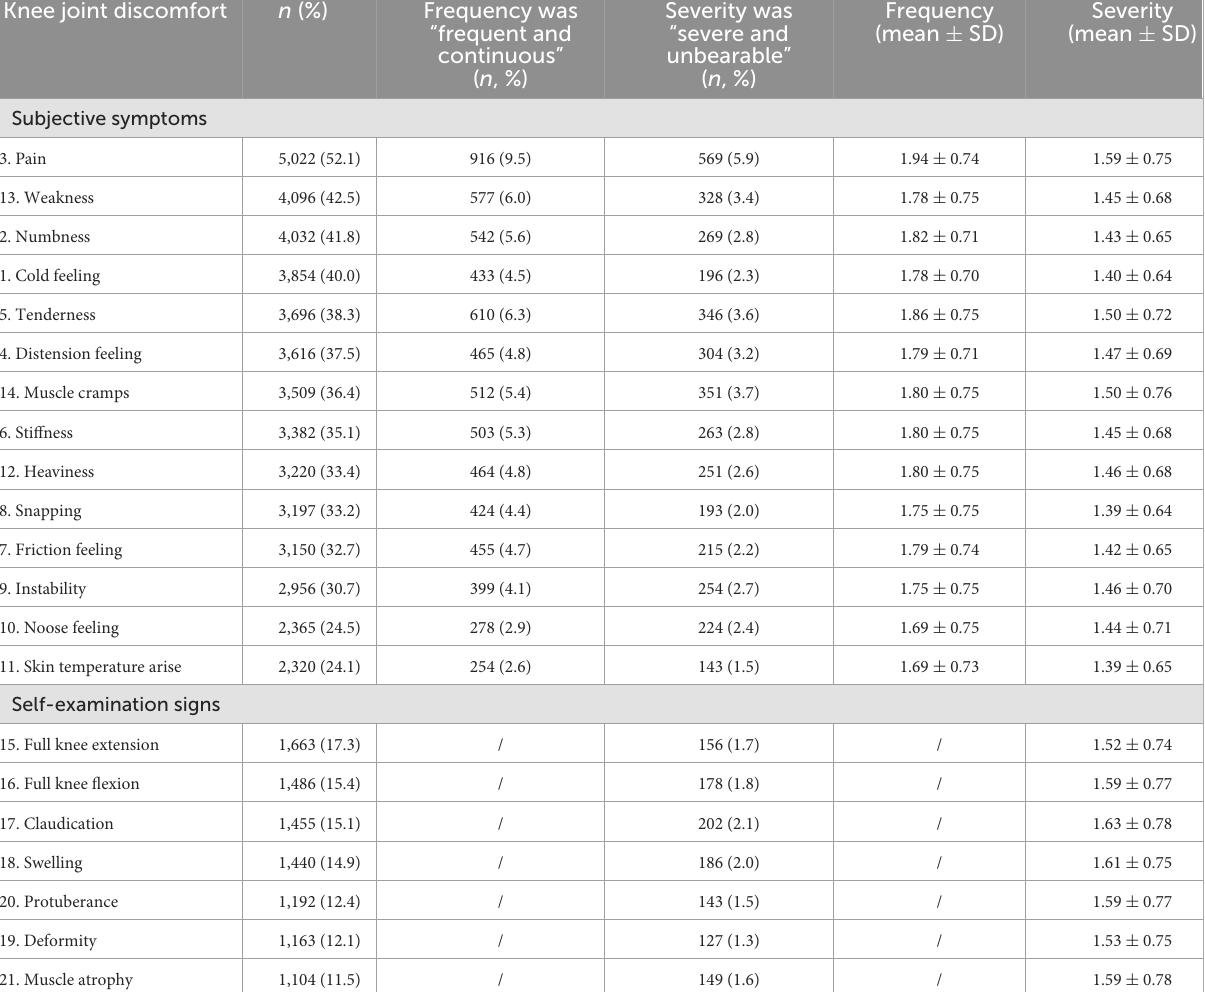
TABLE 2 Prevalence of knee joint discomfort among the middle-aged and elderly people ( n = 9,640). Knee joint